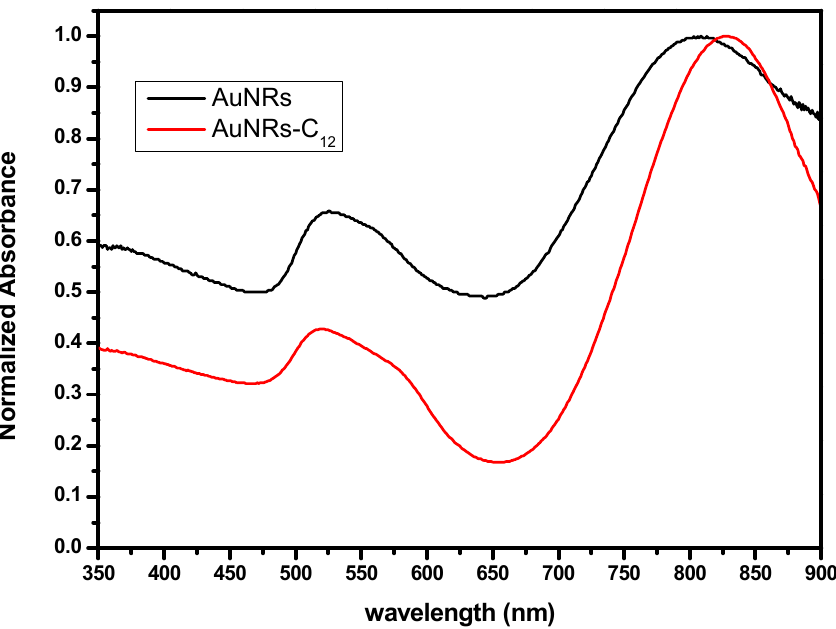
Figure 3. UV spectra of AuNRs (black) and AuNRs-C 12 (red) dispersed in DMSO. Through elemental analysis, it was possible to determine the quantity of 12-MDA bound to AuNRs. In particular, it was observed that the abundance of gold atoms was about six-fold higher (5.94) than the carbon atoms abundance (Figure